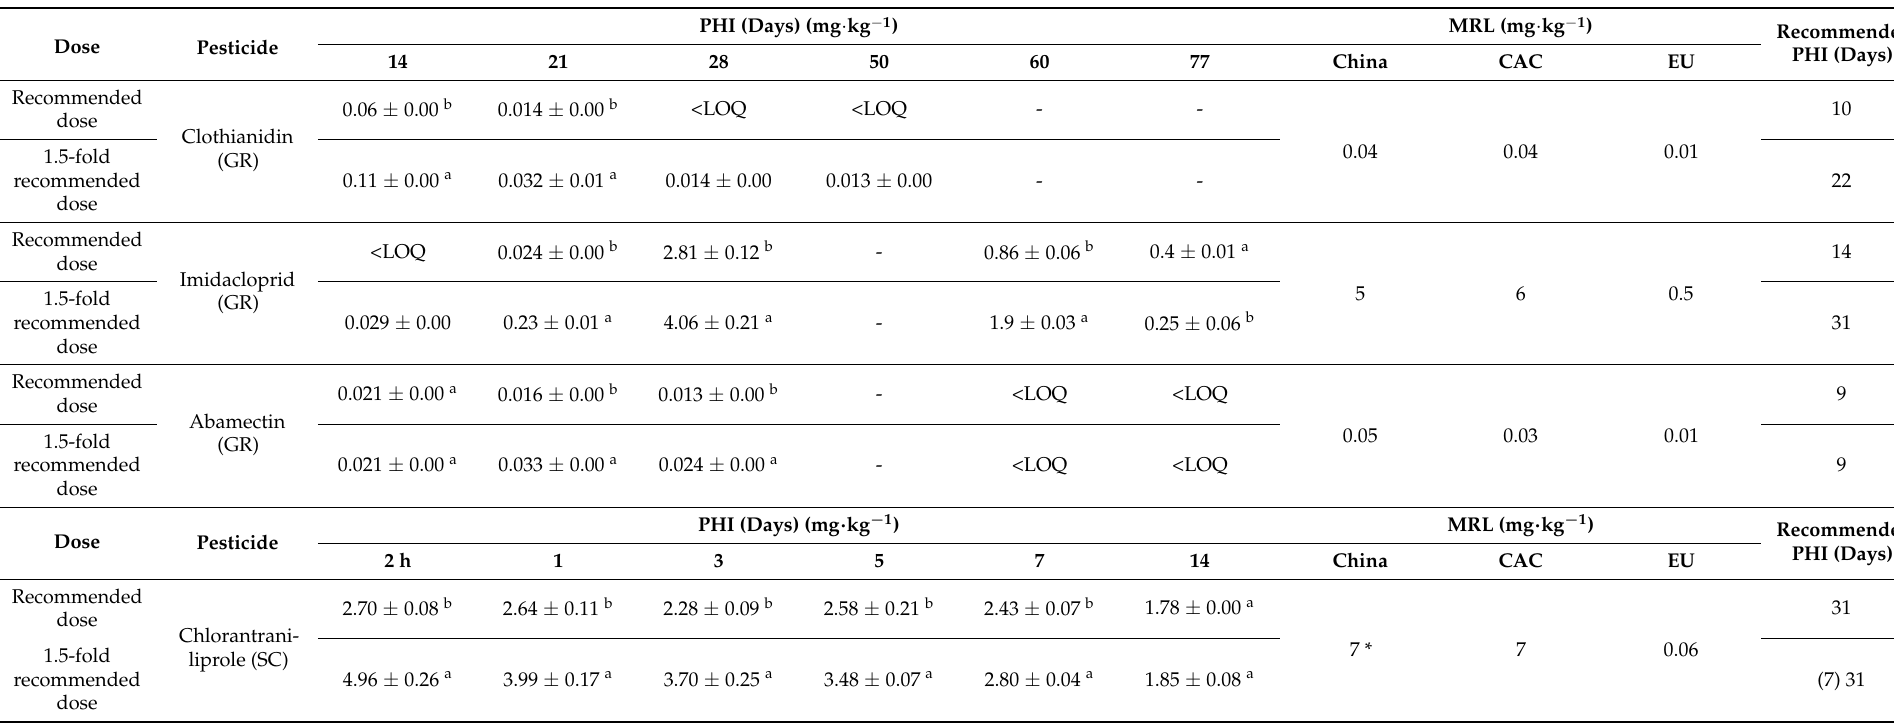
Table 4. Residue levels at different pre-harvest intervals after application of the recommended dose and 1.5-fold the recommended